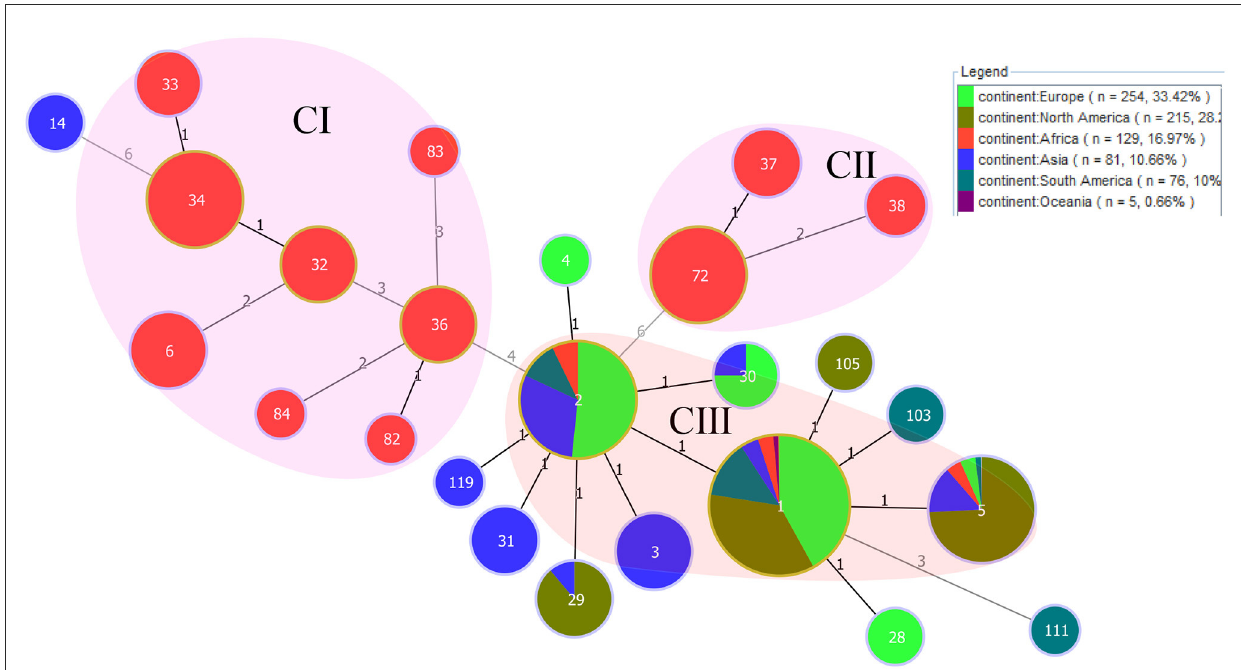
FIGURE2 PHYLOViZ analysis showing the genetic relationships among STs of 760 B. abortus strains. Color coding according to continents. Circle size indicates the number of strains. Each circle represents a distinct ST, and the STs from the present study are shaded in pink (C I, C II) and light red (C III)